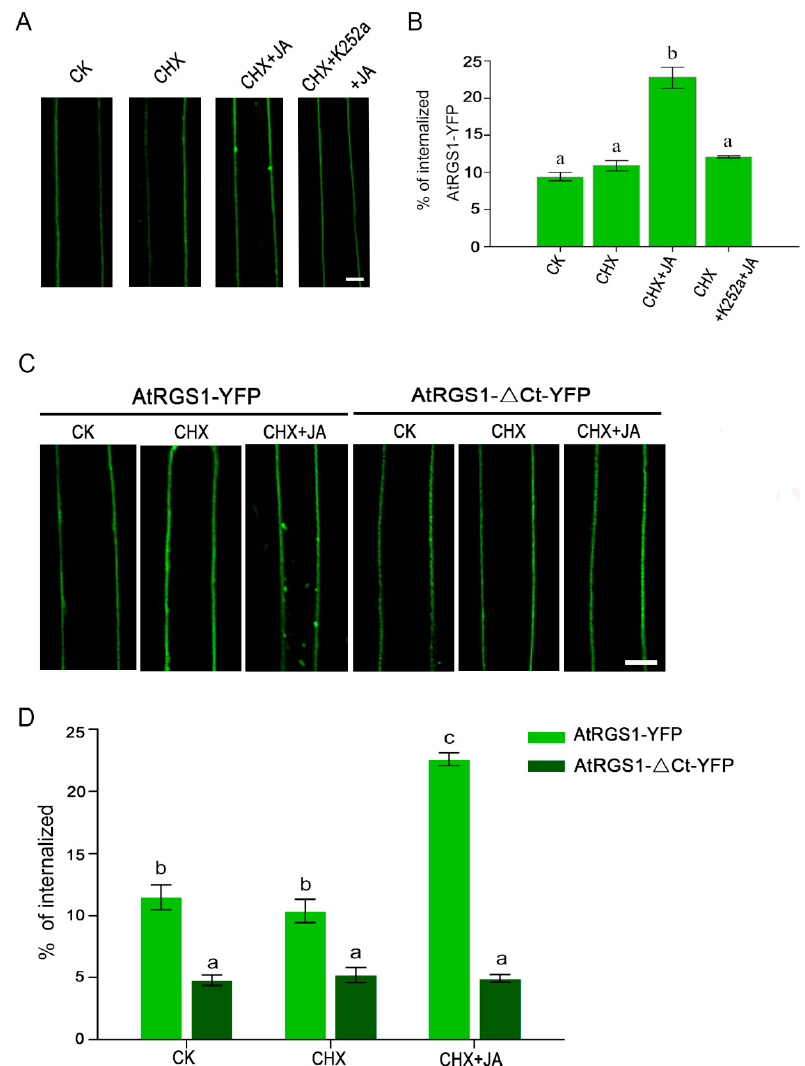
Figure 5. Phosphorylation and the C-terminal domain are required for AtRGS1 endocytosis. ( A ) Confocal images of AtRGS1-YFP localization without treatment (CK), with CHX treatment, with MeJA treatment for 8 h plus CHX pretreatment, and with MeJA treatment for 8 h plus CHX and K252a pretreatment in an Arabidopsis hypocotyl epidermal cell. Bar = 10 µ m. ( B ) Quantification of the internalized AtRGS1-YFP without treatment (CK), with CHX treatment, with MeJA treatment for 8 h plus CHX pretreatment, and with MeJA treatment for 8 h plus CHX and K252a pretreatment. Error bars represent SD ( n = 5–8). Significant di ff erences are denoted by letters (Duncan multiple-comparisons test; values within the column followed by the same letter show no significant di ff erence ( p > 0.05), whereas those with di ff erent letter indicate significant di ff erence ( p < 0.05)). ( C ) Confocal images of AtRGS1-YFP and AtRGS1- ∆ Ct-YFP without treatment (CK), with CHX treatment, and with MeJA treatment for 8 h plus CHX pretreatment in an Arabidopsis hypocotyl epidermal cell. Bar = 10 µ m. ( D ) Quantification of the internalized AtRGS1-YFP or AtRGS1- ∆ Ct-YFP without treatment (CK), with CHX treatment, and with MeJA treatment for 8 h plus CHX pretreatment. Error bars represent SD ( n = 5–8). Significant di ff erences are denoted by letters (Duncan multiple-comparisons test; values within the column followed by the same letter show no significant di ff erence ( p > 0.05), whereas those with di ff erent letter indicate significant di ff erence ( p <